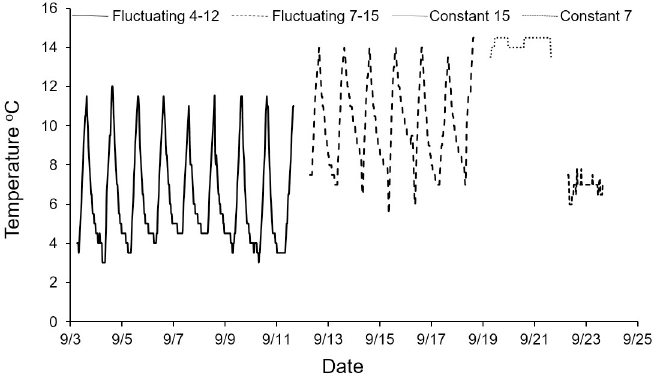
Fig 1. Fluctuating and constant temperature regimes applied during wild bull trout aquarium